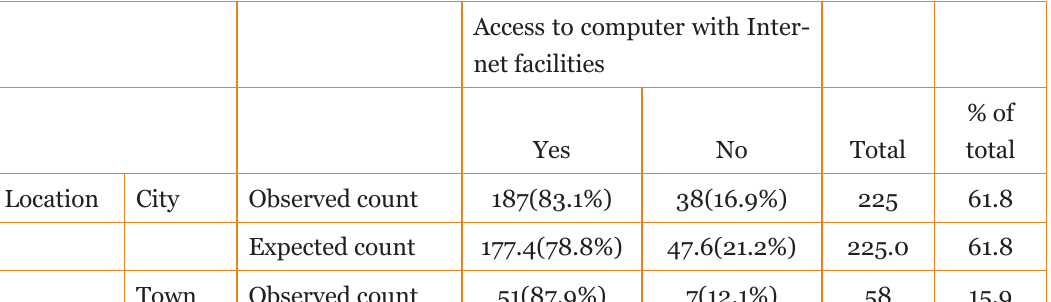
Location and Access to Computer with Internet Facilities